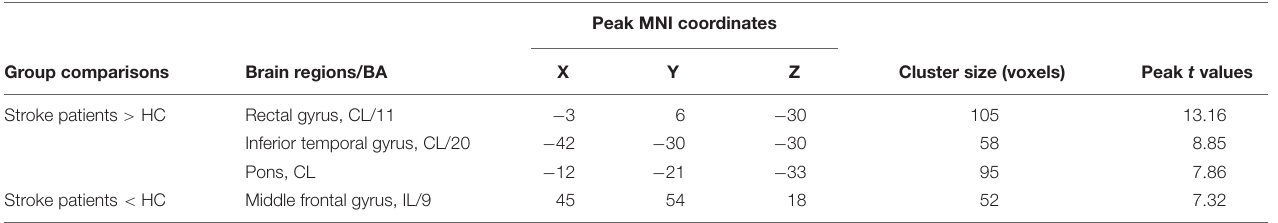
TABLE 3 | Brain regions with significant differences in dynamic ReHo between